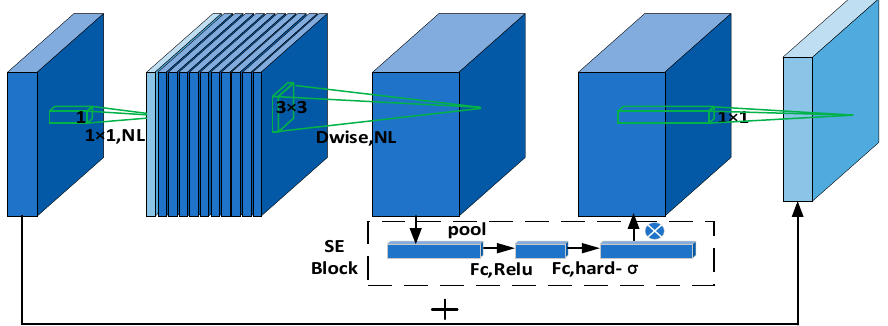
Figure 7. MobileNetv3 network module structure.